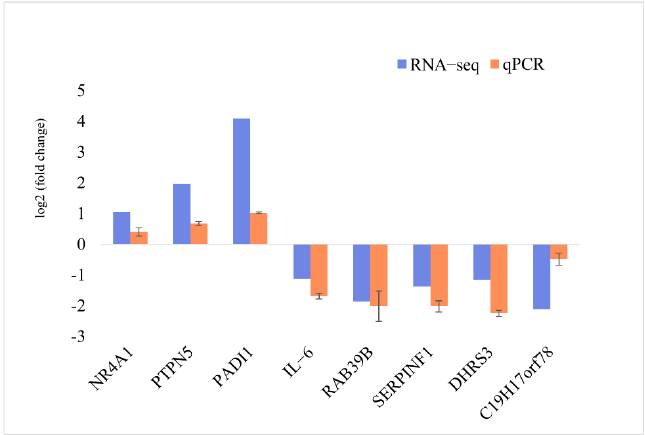
Figure 4. qPCR validation of the DIE-mRNAs identified by RNA-seq analysis.